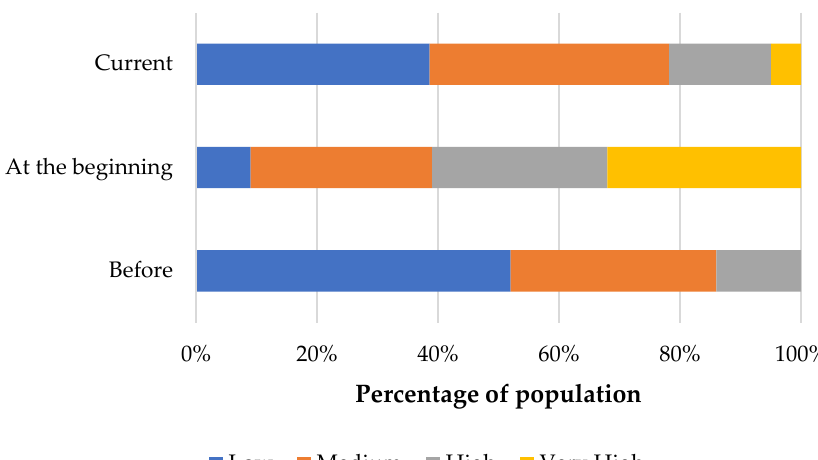
Figure 4. Stress level distribution before, at the beginning of the COVID-19 pandemic, and at the time of questionnaire completion.